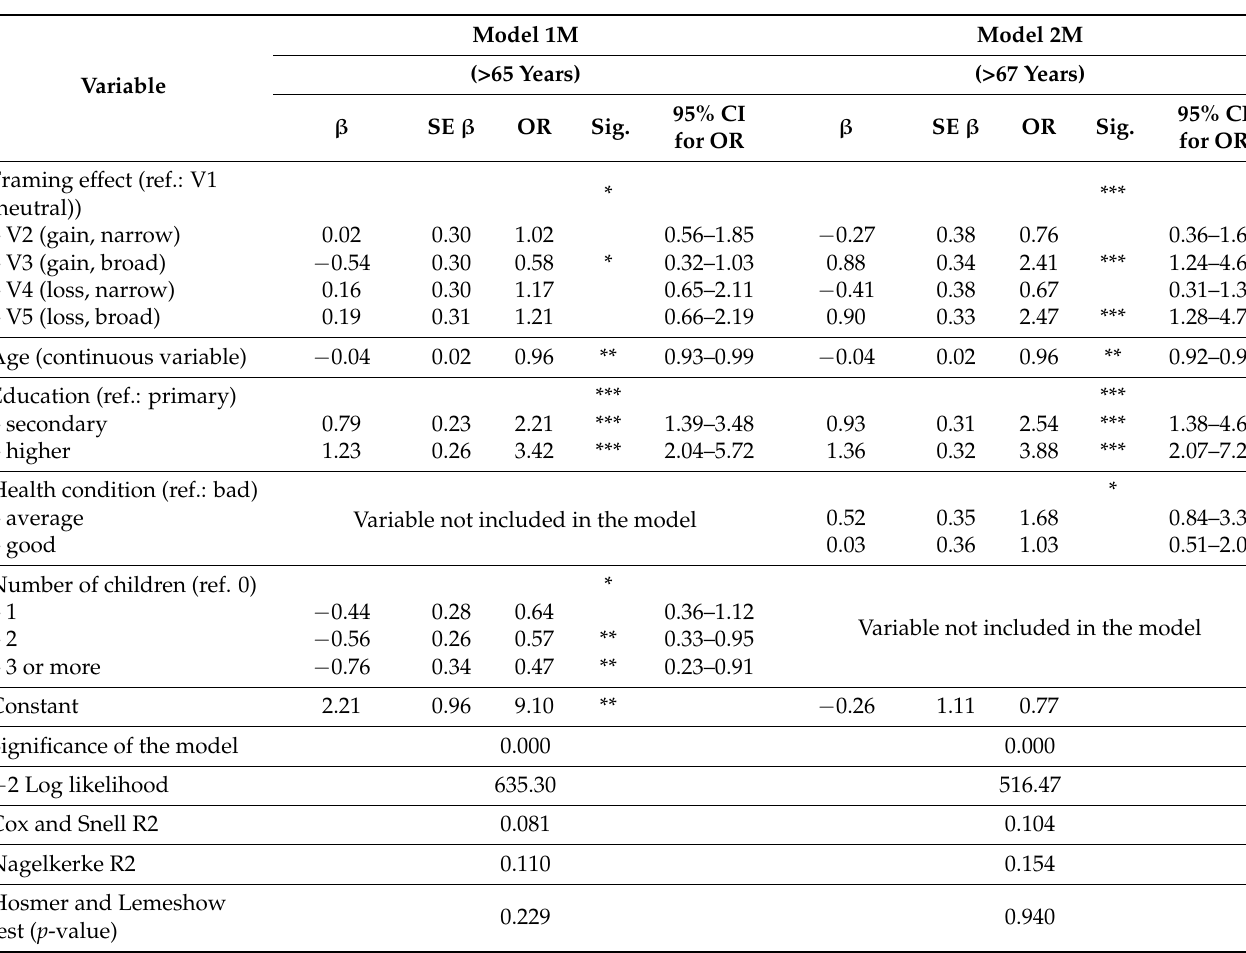
Table A4. Logistic Regression Models of Planned Retirement Age